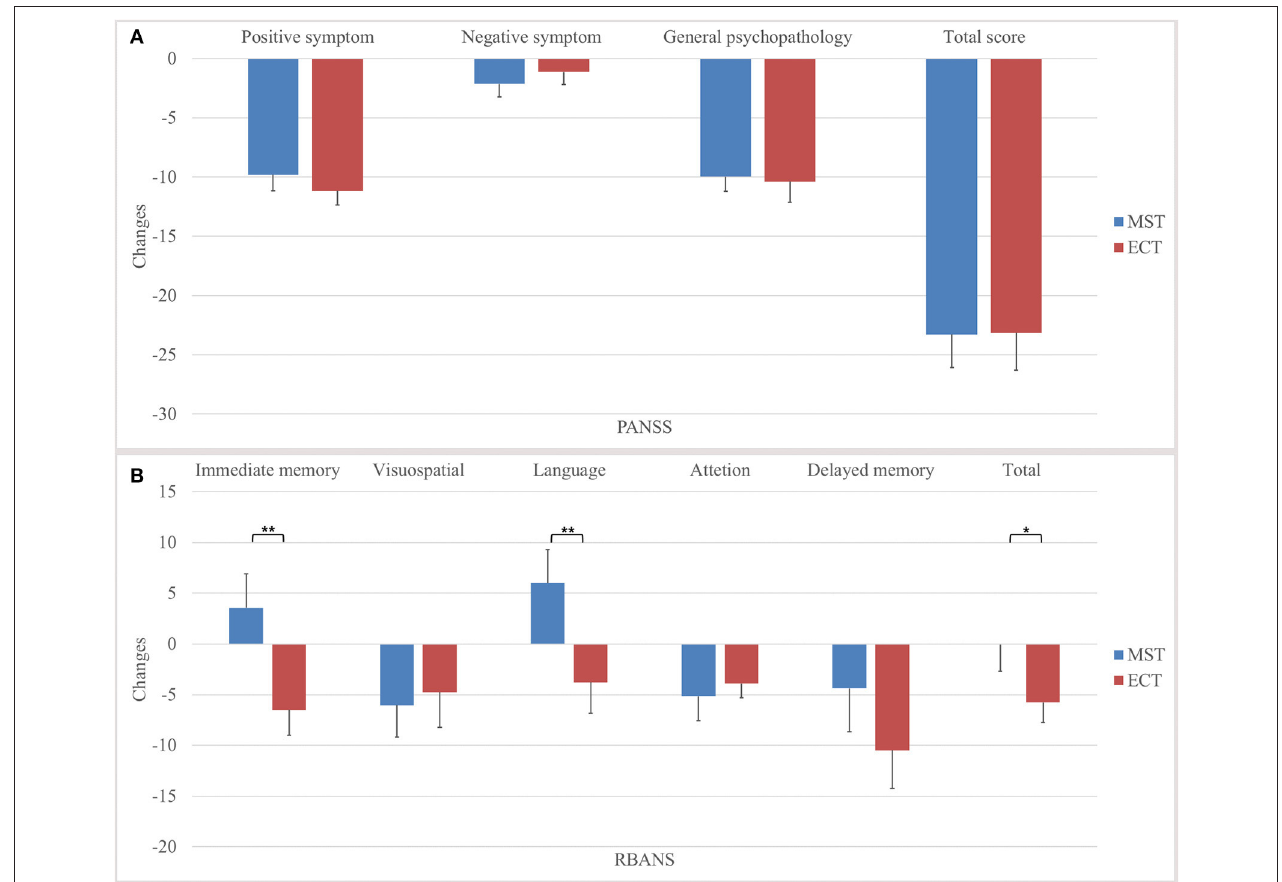
FIGURE 2 | Changes in psychotic symptoms and cognitive functions in the intention-to-treat dataset. We found no significant differences between MST and ECT in the (A) changes of total score and subscale scores of PANSS, but significant differences were found in the (B) changes of immediate memory, language, delayed memory, and total index of RBANS. * p ≤ 0.05, ** p ≤ 0.01. PANSS, positive and negative syndrome Scale, RBANS, repeatable battery for the assessment of neuropsychological status, MST, magnetic seizure therapy, ECT, electroconvulsive